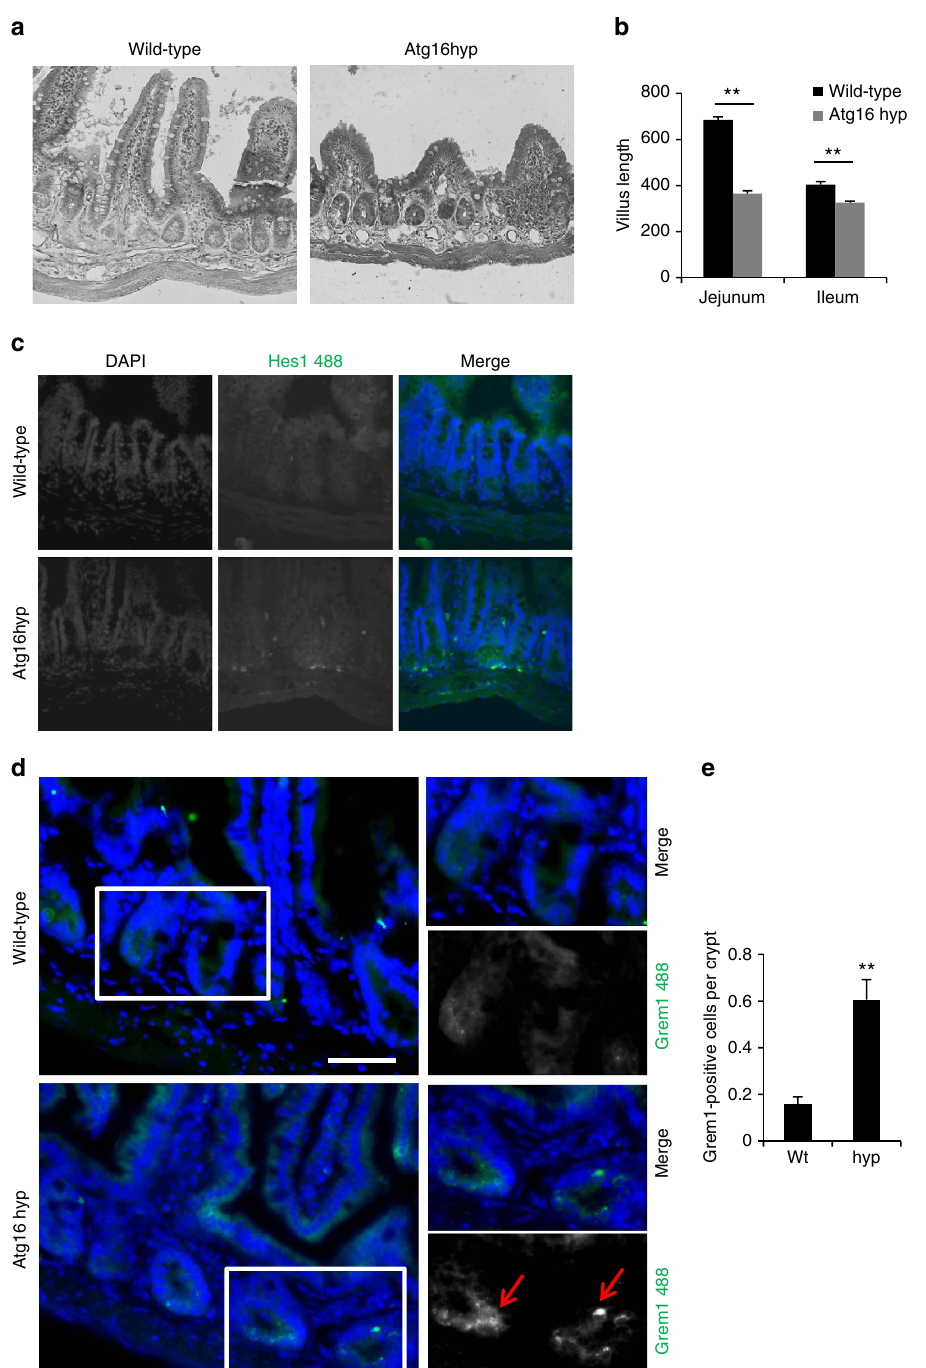
Figure 10 | Atg16L1 hypomorphs show developmental retention in the gut. ( a ) Effect of decreased Atg16L1 levels on growth of gut villi length. Representative gut section from wild-type and Atg16L1 hypomorph (Atg16hyp) 10–15 weeks old mice. ( b ) Quantification of villi length from wild-type and Atg16L1 hypomorph (Atg16hyp) 10–15 weeks old mice. ** P o 0.01 by unpaired t -test. n ¼ 4. Error bars ¼ s.e.m. ( c ) Hes1 immunostaining in gut from wild-type and Atg16L1 hypomorph (Atg16hyp) mice. ( d ) Grem1 immunostaining in gut from wild-type and Atg16L1 hypomorph (Atg16hyp) mice. ( e ) Quantification of Grem1-positive cells per crypt in wild-type and Atg16L1 hypomorph (Atg16hyp) mice. ** P o 0.01 by paired t -test. n ¼ 3. Error bars ¼ s.e.m. Scale bar, 50 m